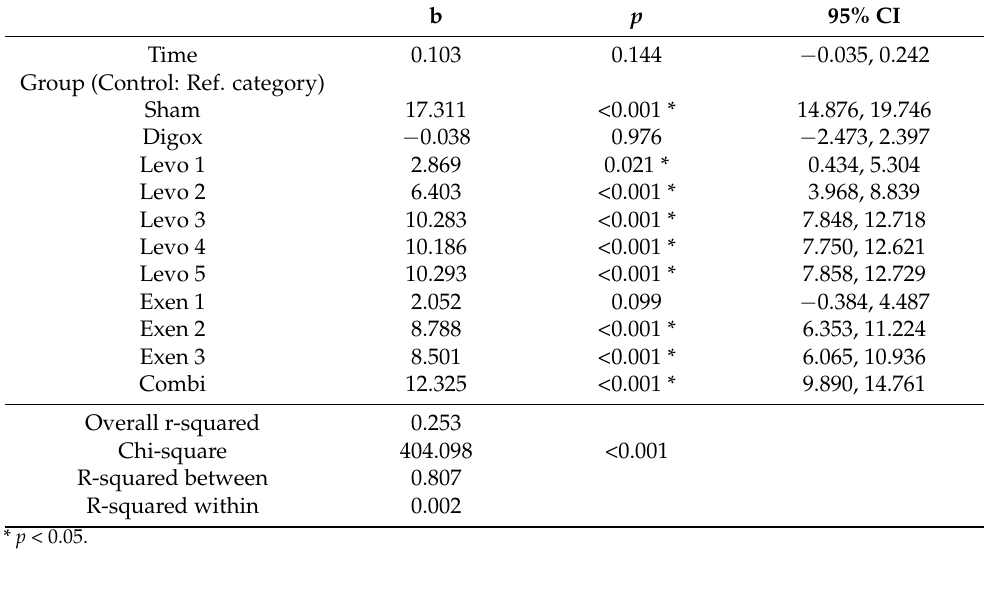
Table 5. Longitudinal analysis for RPP for all groups.